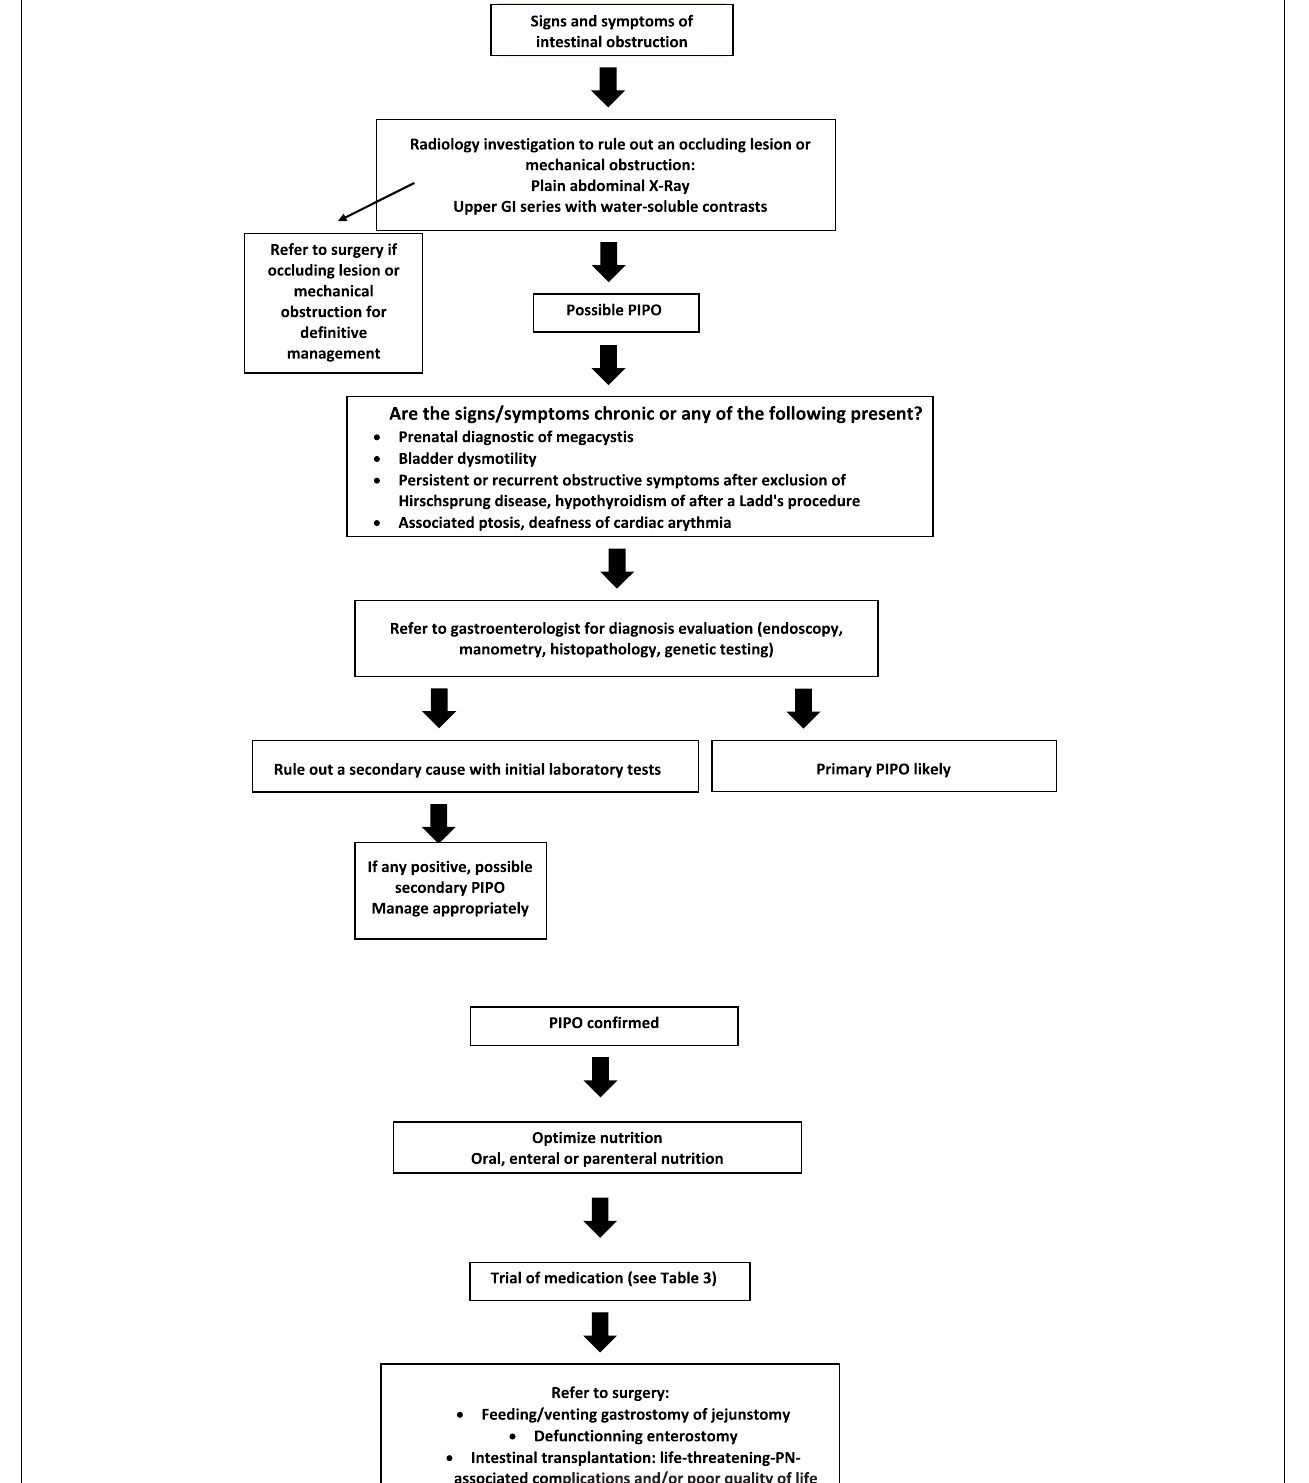
FIGURE 1 | Algorithm for diagnosis and management of Pediatric Intestinal Pseudo-Obstruction.